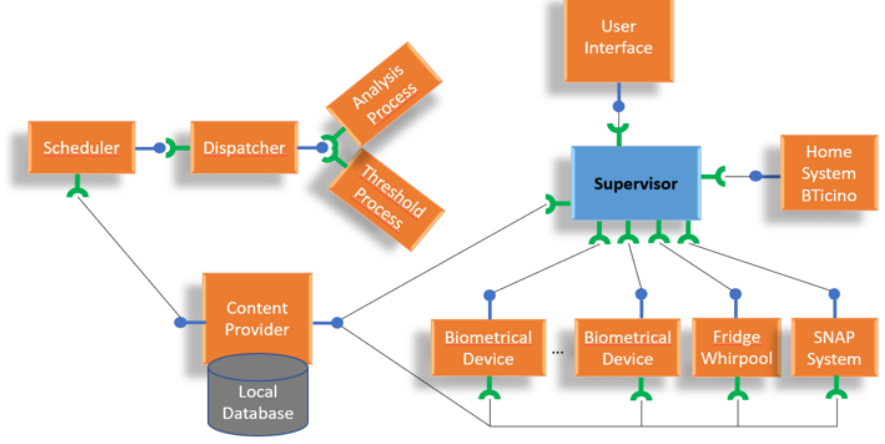
Figure 5. The developed bundles